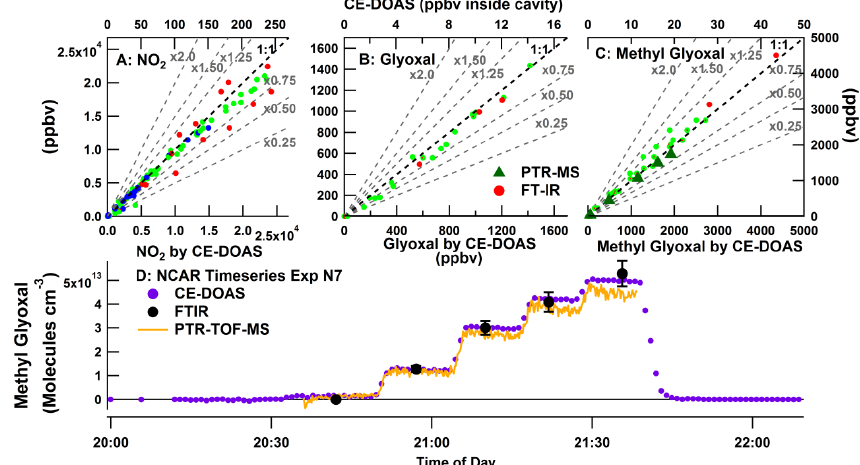
Figure 2. Correlation of FT-IR and PTR-ToF-MS relative to CE-DOAS for experiments N1–N9 at NCAR (NO 2 includes additional experi- ments, see text). Data from individual experiments have been pooled at different temperatures. (a–c) FT-IR (dots), PTR-ToF-MS (triangles), three temperatures (blue – 260K, green – 293K, red – 330K). (d) Time series for experiment N7 to produce methyl glyoxal. For display on these graphs, units in (a–c) (moleculescm − 3 ) have been converted to volume mixing ratios using a single chamber temperature and pressure (295K, 800Torr) representing the typical conditions at the start of room temperature